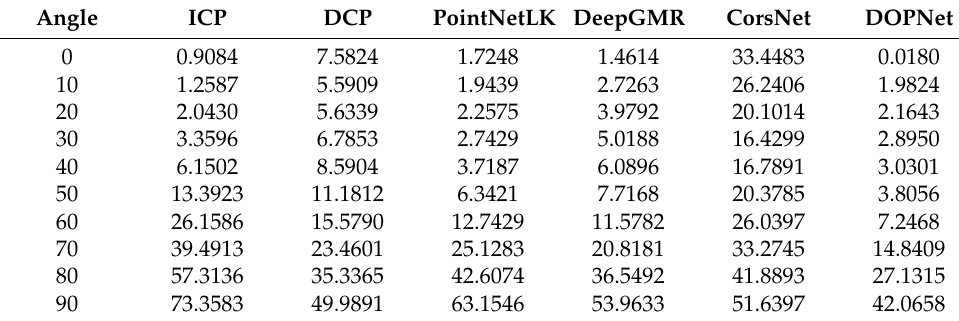
Figure 4. Generalization to the initial rotation angle. ( a ) denotes Error(R), ( b ) denotes Error(t). Table 3. Results of Error(R).